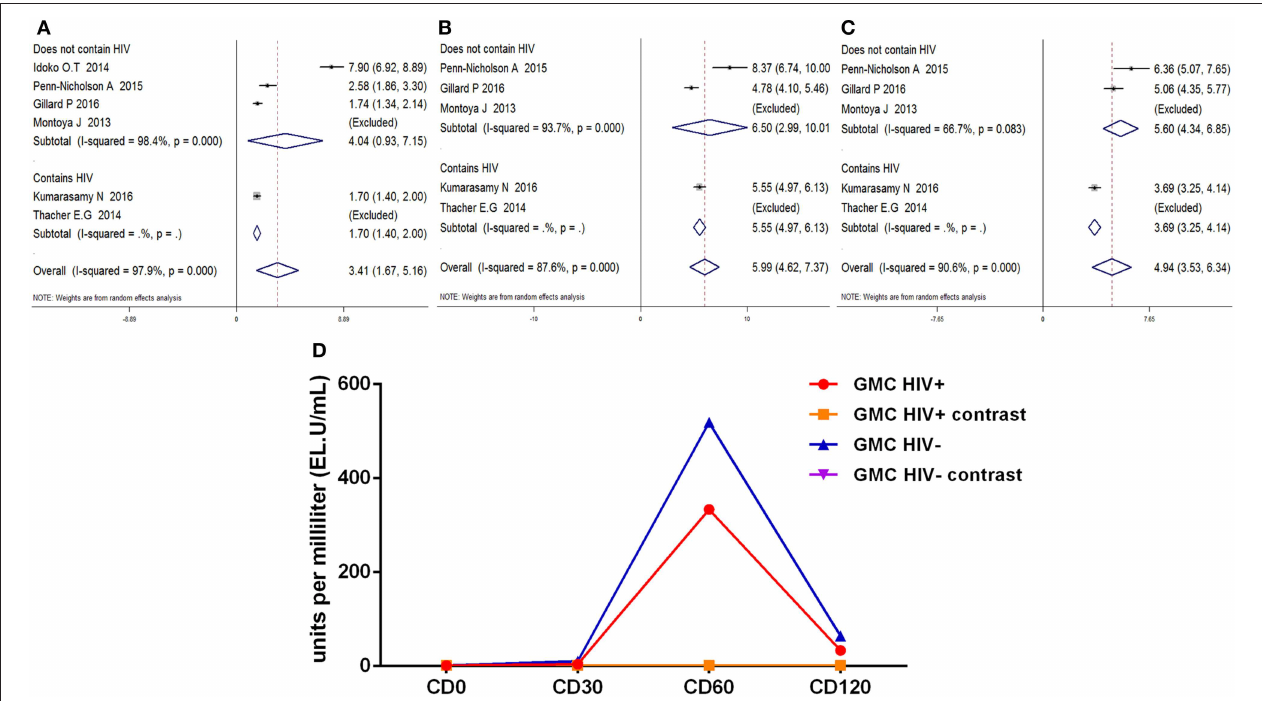
FIGURE 8 | Subgroup analysis Anti-M72 antibody IgG geometric mean concentration(GMC). (A–C) Forest plot: SMD > 0 indicates that the vaccine was protective. SMD = 0, invalid result. Point estimates and 95%CI are shown for each study and for the pooled results. (D) Line chart: the anti-M72 IgG GMC varies (Ordinate) with time in different time points (Abscissa) after